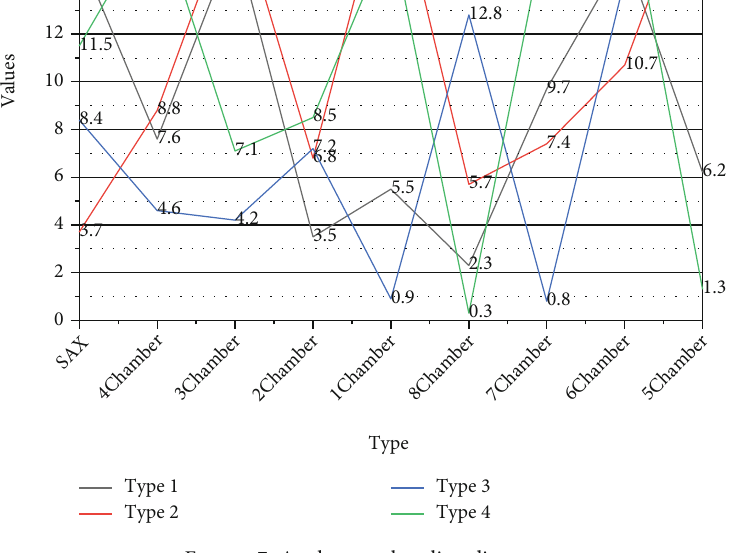
Figure 7: Angle error box line diagram.